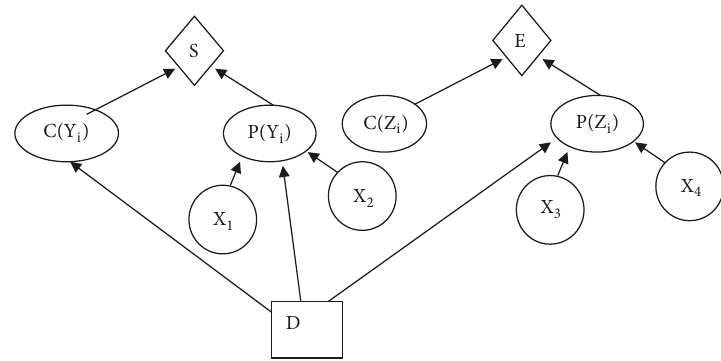
Figure 4: Complete influence diagram with different risk